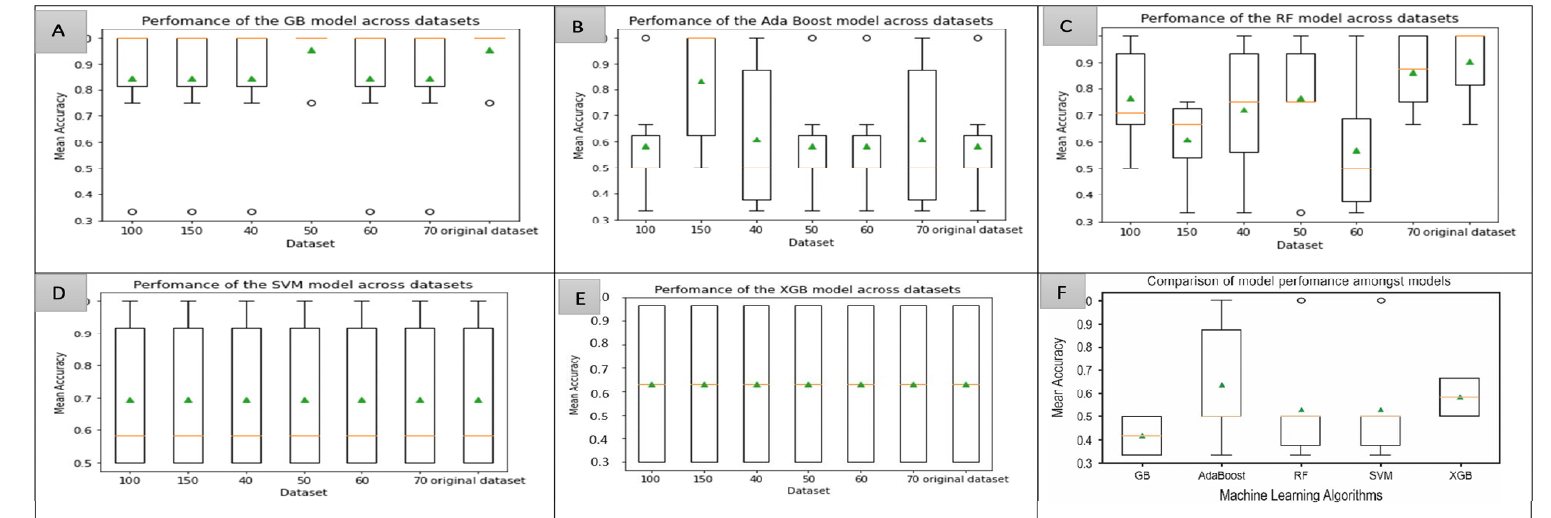
Figure 9. The boxplot shows the mean (yellow line), the low and upper quantile (black whiskers) comparison of the model performance across datasets and among the models using students paired t ‐ test, where ( A ) represents the gradient boosting; ( B ) AdaBoost; ( C ) random forest; ( D ) support vector machines; ( E ) eXtreme gradient boosting; while ( F ) depicts the comparison of model performance amongst models, respectively. From the x ‐ axis, the 100, 150, 40, 50, 60, 70, and original dataset labels correspond to Dataset 1, Dataset 2, Dataset 3, Dataset 4, Dataset 5, Dataset 6, and Dataset 7, respectively. The green triangles represent the mean in relation to the overall performances of each classifier per dataset.